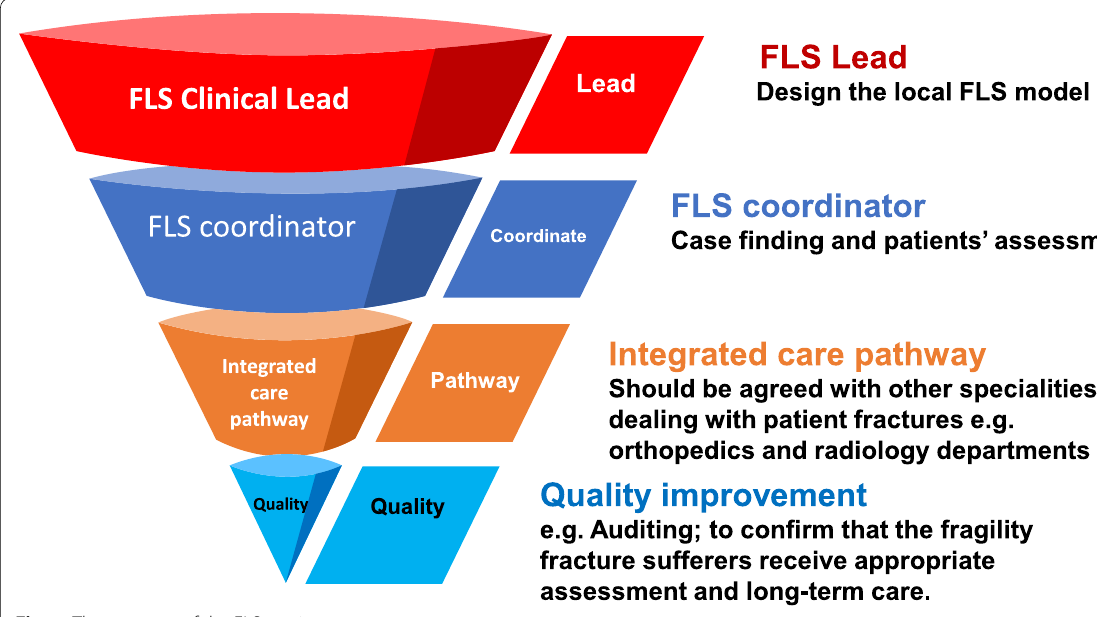
Fig. 1 The structure of the FLS